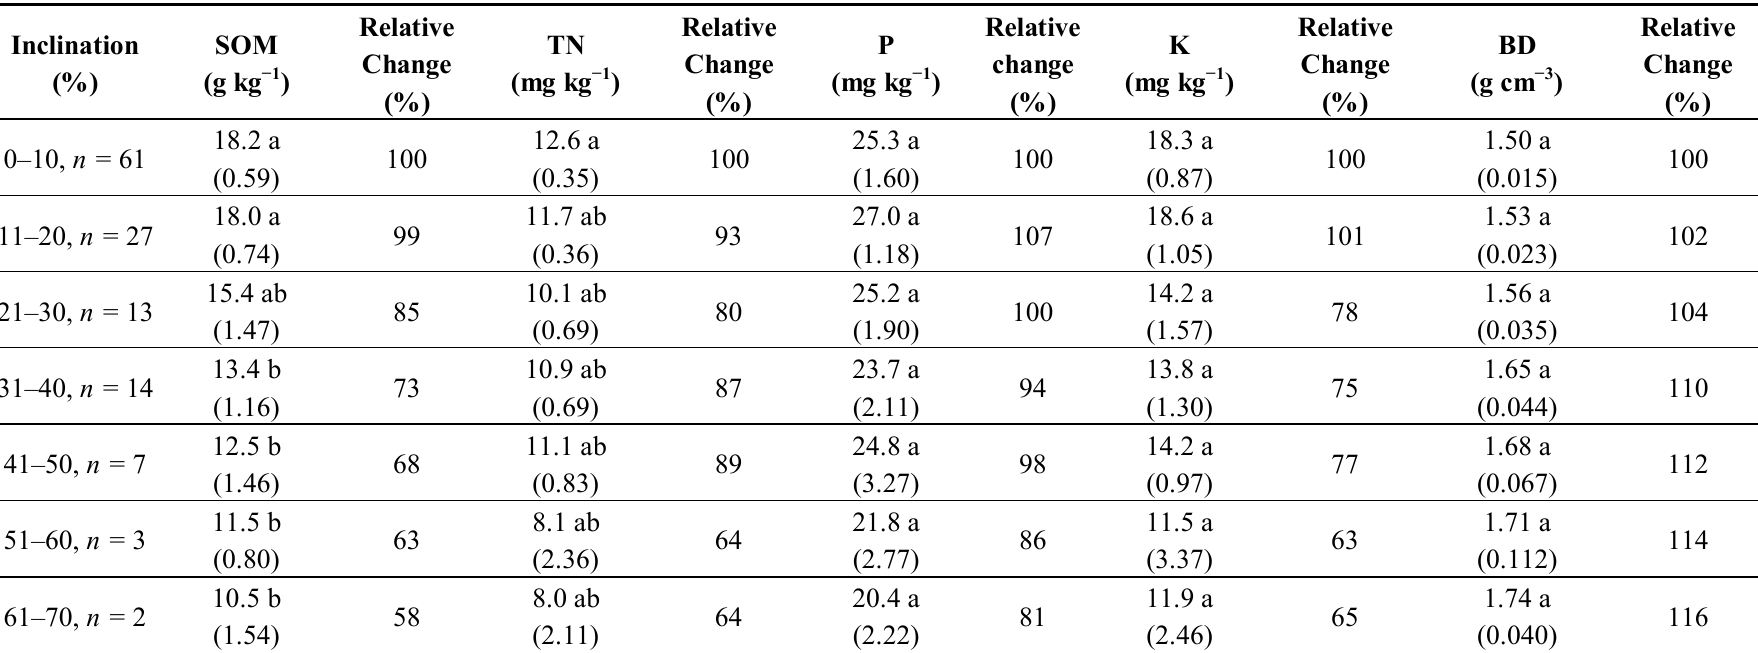
Table 2. Organic matter (OM), total nitrogen (TN), available phosphorus (P), extractable potassium (K) and bulk density (BD) of maize fields on 92 farms, and relative changes with increasing inclination levels, with 0%–10% as the benchmark of 100%.